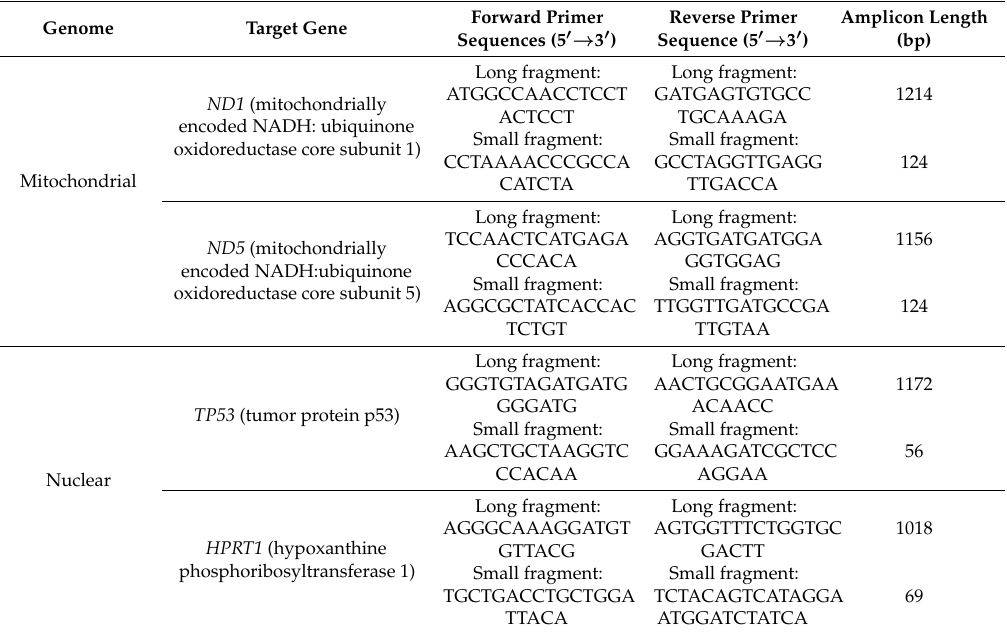
Table 2. Sequence of oligonucleotides used in this